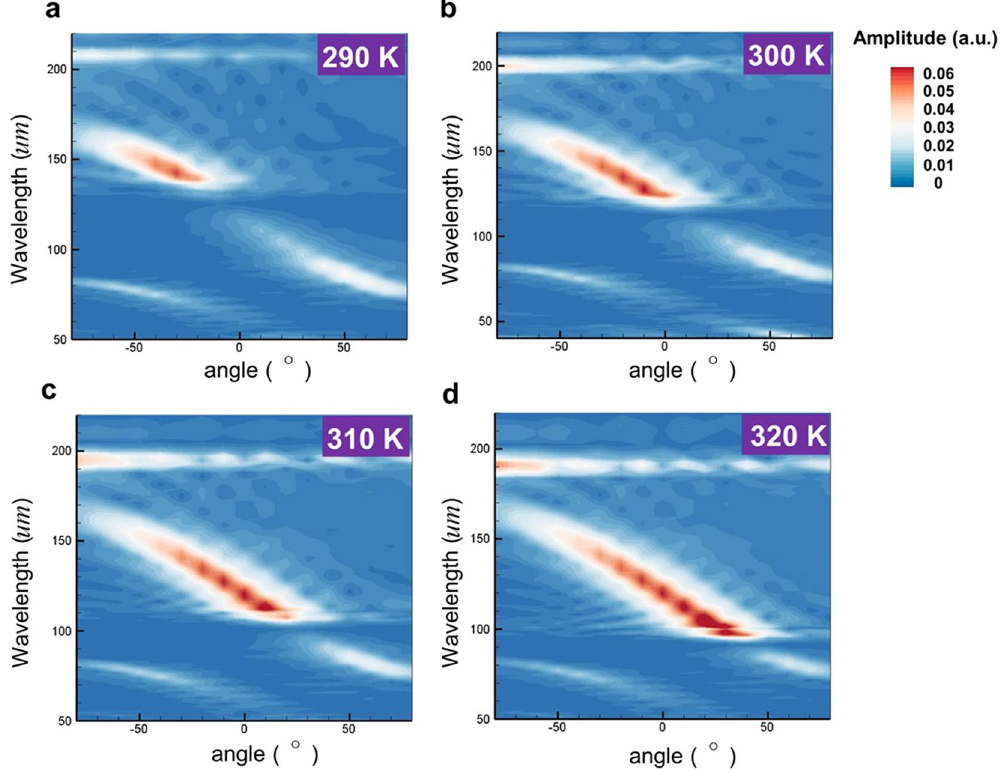
Figure 5. Simulated results for temperature effects on SP-enhanced SPR on an InSb grating. ( a ), ( b ), ( c ), and ( d ) Simulated contours of Fourier spectra of Hz fields versus emission wavelength and angle at the observation points with investigated temperatures of 290 K, 300 K, 310 K, and 320 K, respectively. E = 40 keV and h = 22.5 u